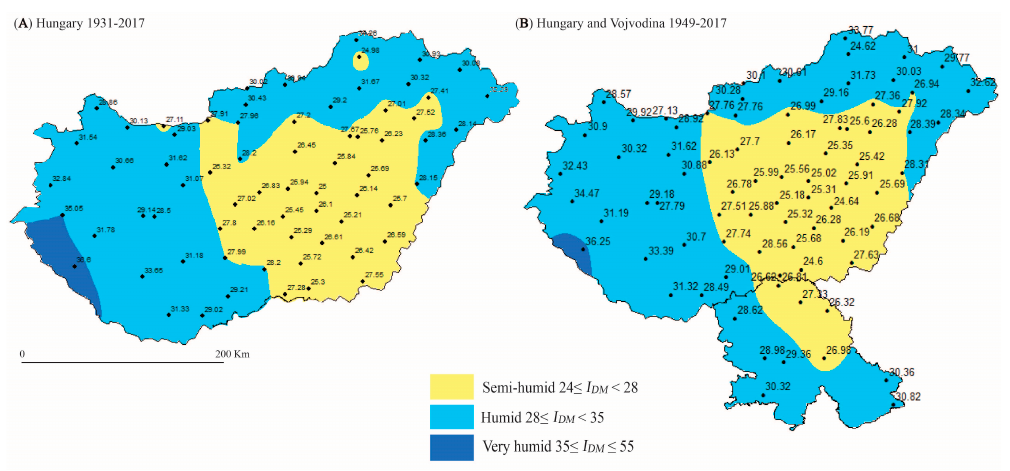
Figure 2. The spatial distribution of the annual De Martonne Aridity Index for: ( A ) Hungary during the period 1931 – 2017 and ( B ) Hungary and Vojvodina jointly during the period 1949 – 2017.